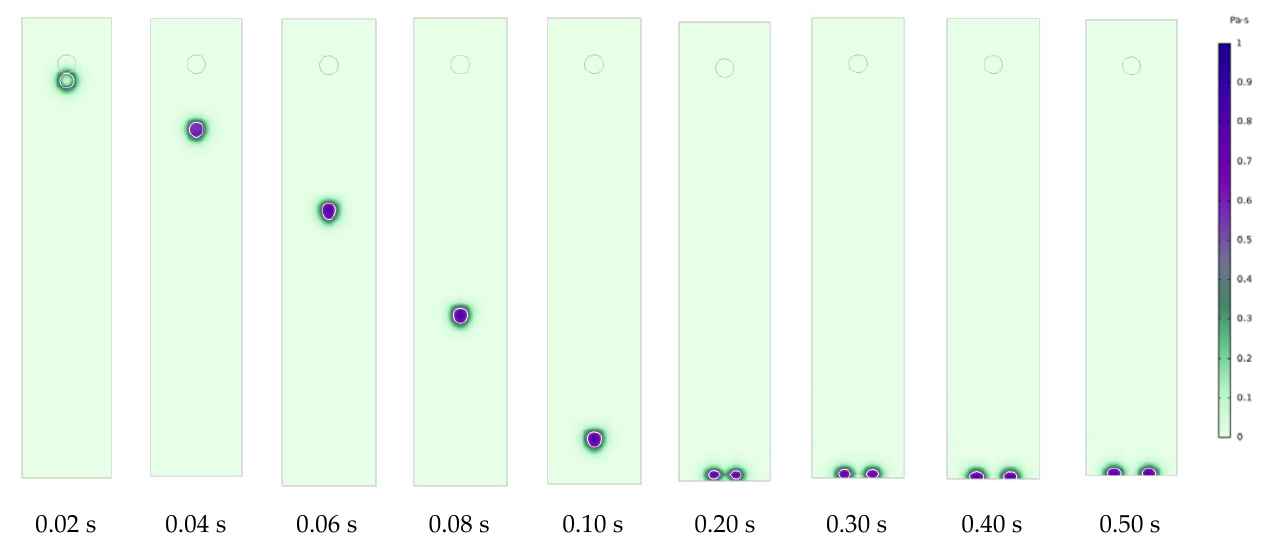
Figure 14. Viscosity of the water droplet in air at 243.15K.